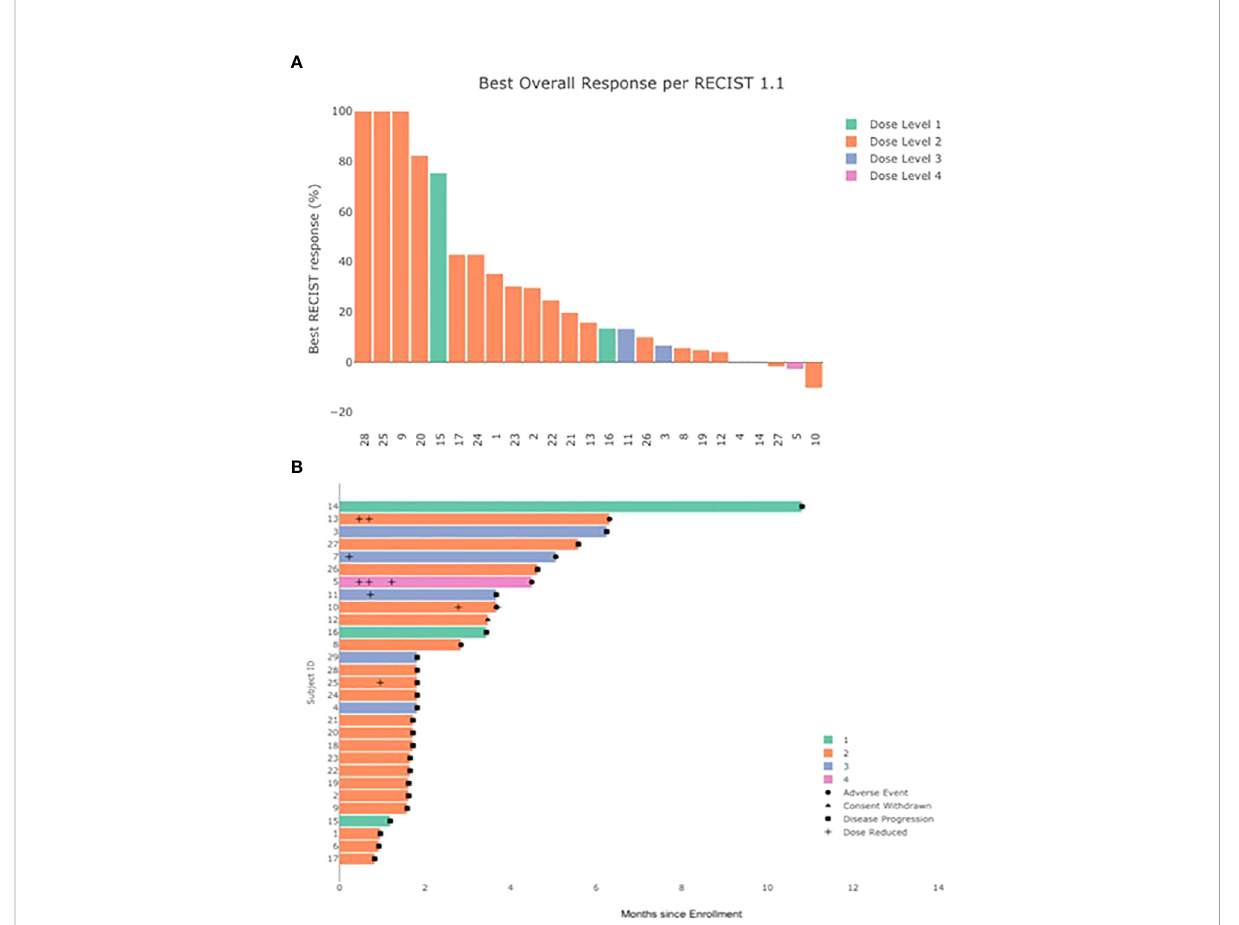
FIGURE 1 Clinical response to treatment. (A) Best % change in sum of target lesions by investigator assessed RECIST v1.1 (by dose level) (B) duration of treatment and time to adverse event, dose reduction, and disease